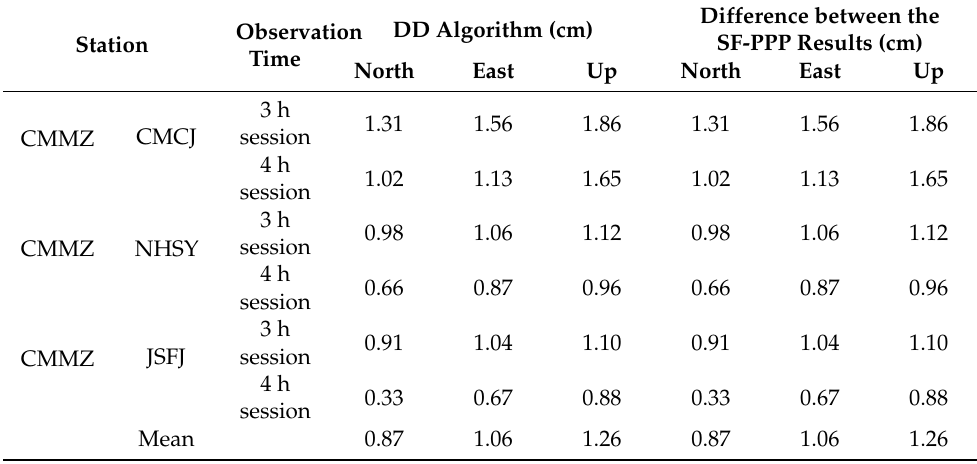
Table 5. Relative positioning accuracy of two